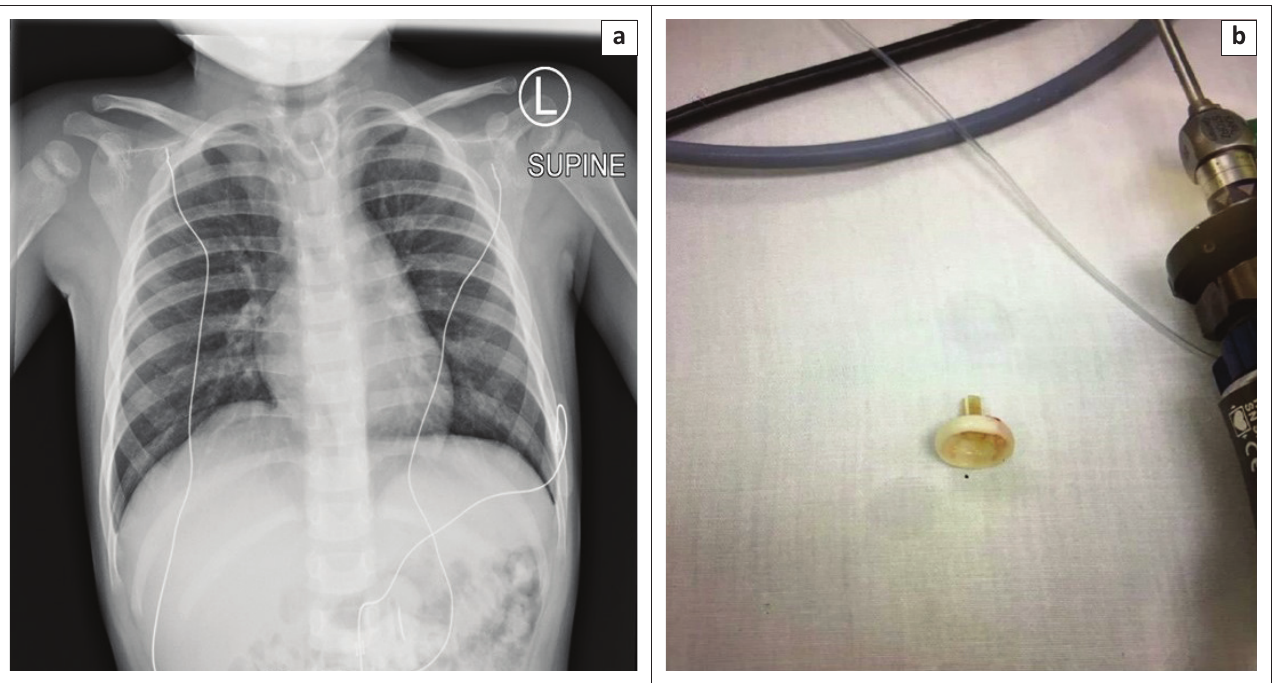
FIGURE 18: Chest radiograph (a) of a 4-year-old child showing a fractured and migrated gastrostomy tube (G-tube) component (b) in the cervical oesophagus. Note that the tracheal air shadow is seen separately, as the migrated G-tube component can mimic a tracheostomy